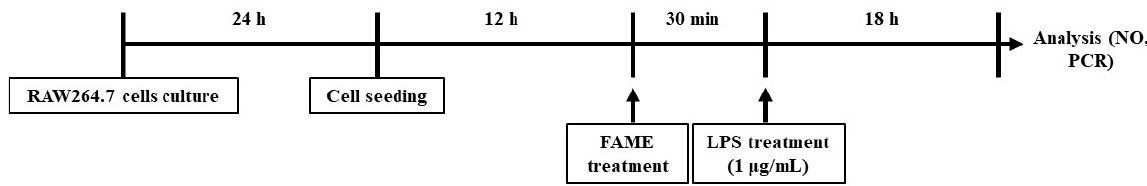
Figure 1. In vitro experimental scheme.